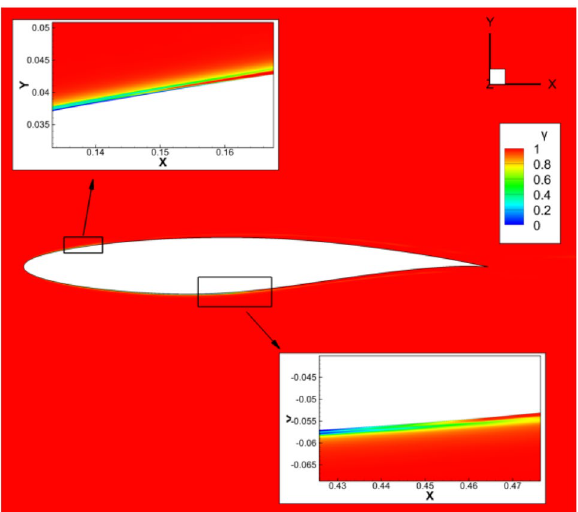
Figure 5. Intermittency factor γ distribution contour.